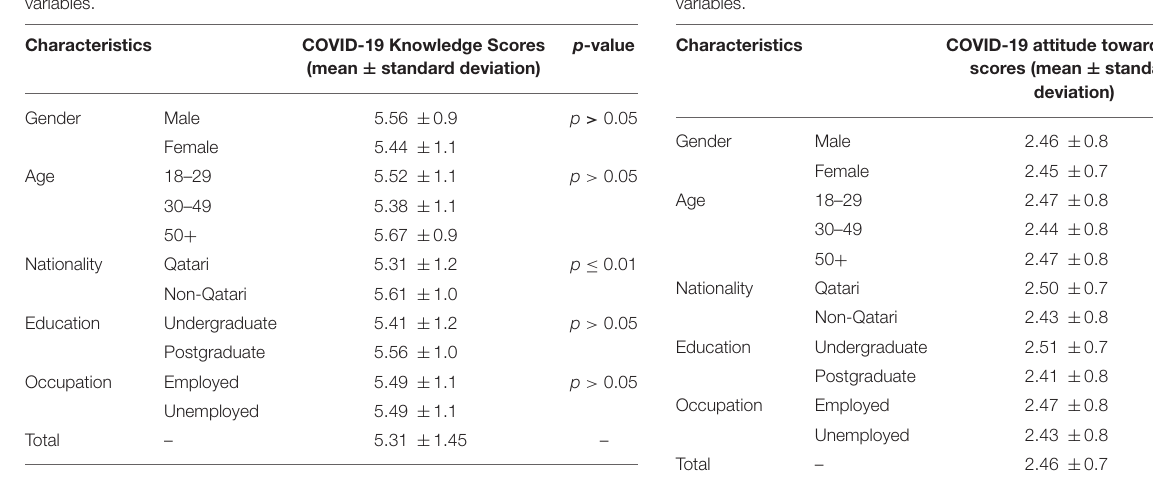
TABLE 4 | Attitude toward COVID-19 laws and rules in Qatar by demographic